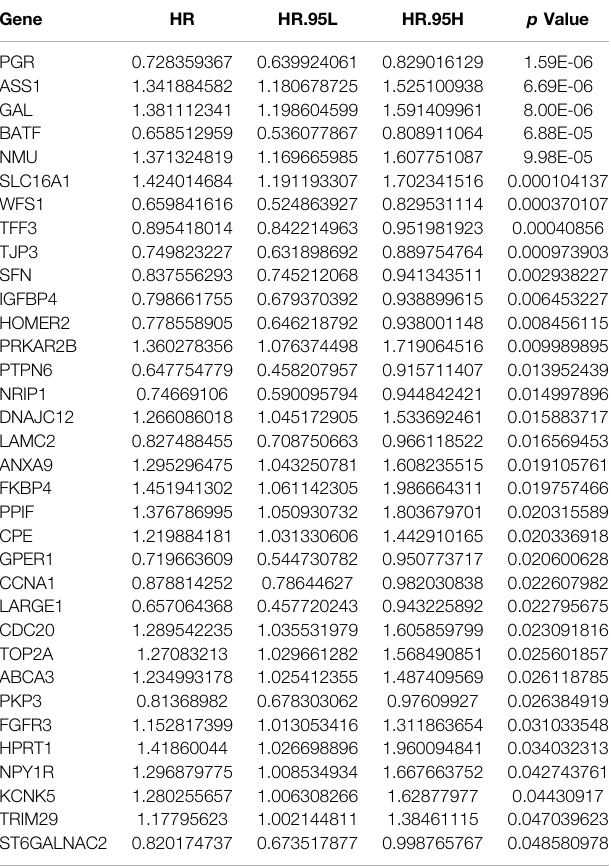
TABLE 1 | 34 genes signi fi cantly associated with OS by univariate Cox proportional hazards regression. Gene